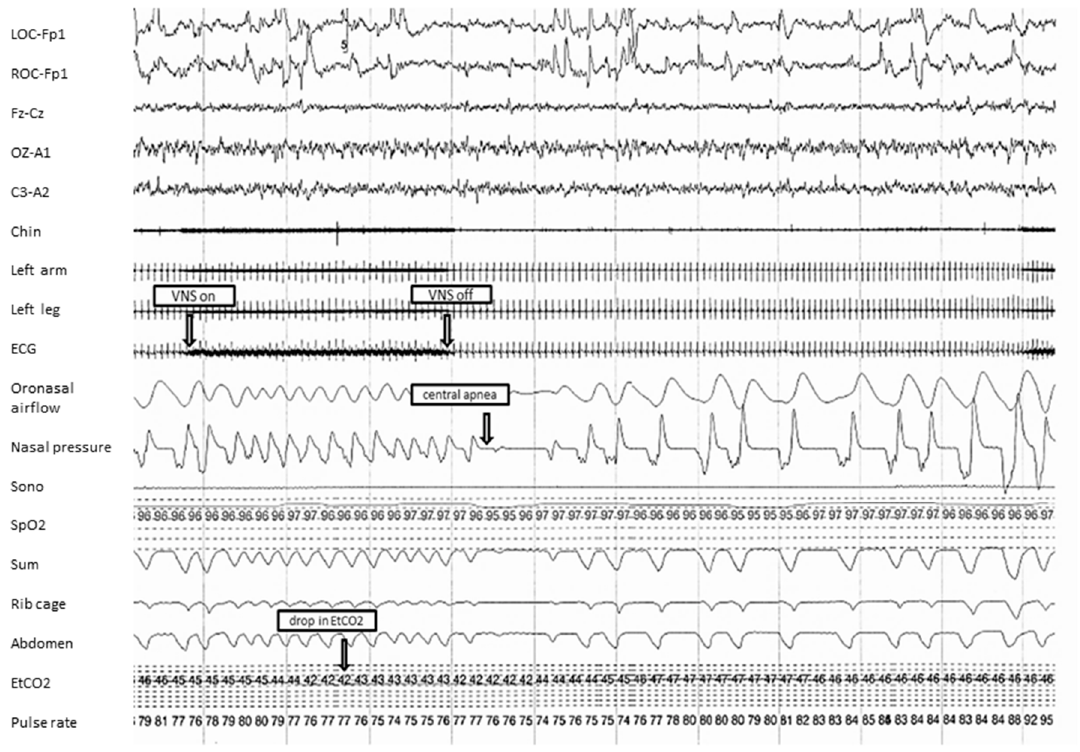
Figure 1. A representative 120-s fragment from the first overnight diagnostic polysomnogram.